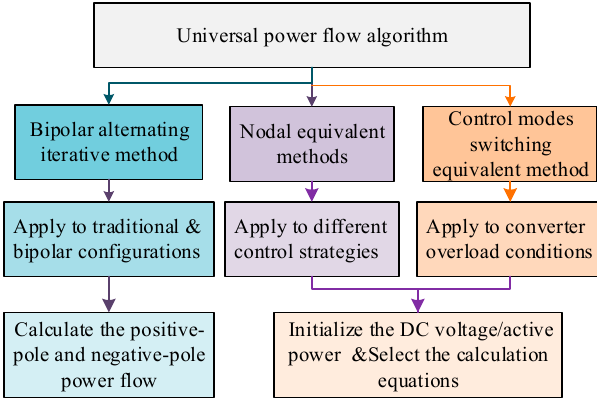
Figure 2. Block diagram of the universal power flow algorithm for VSC-MTDC.